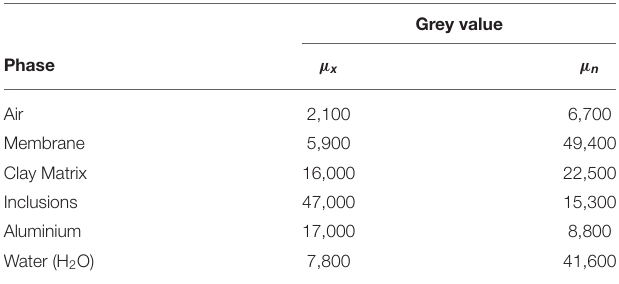
TABLE 2 | Manually-measured average grey values of different phases visually present in µ x and µ n in state 002.